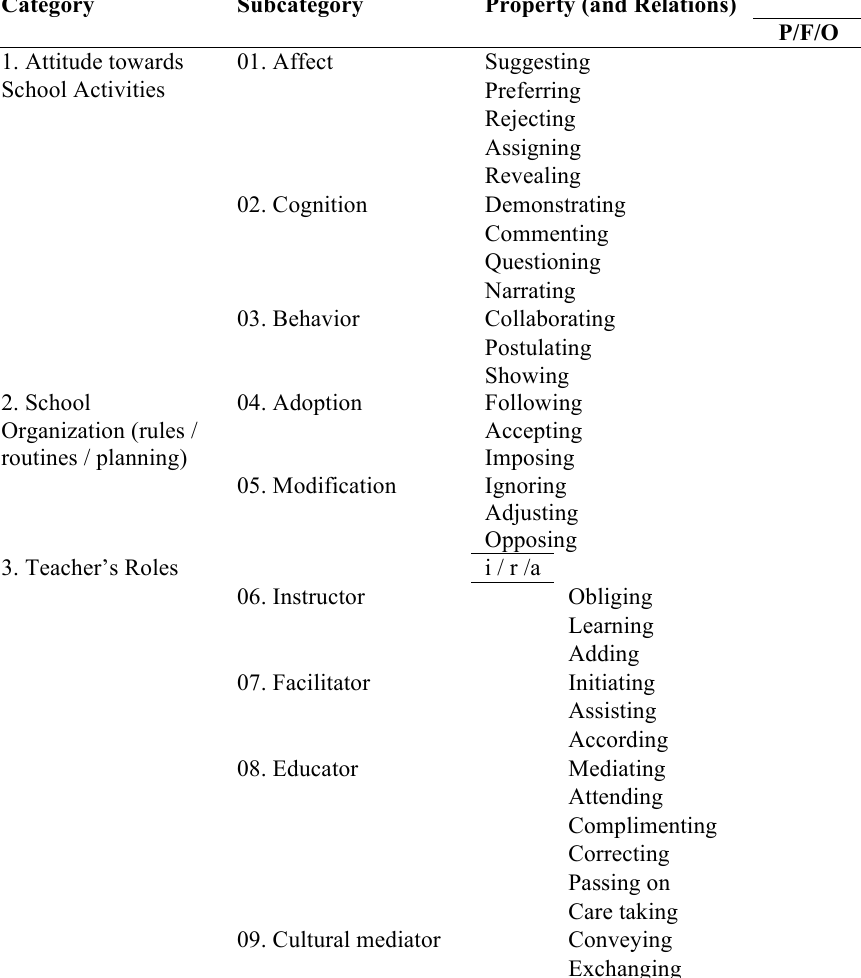
Coding System with Main Categories, Subcategories and Properties